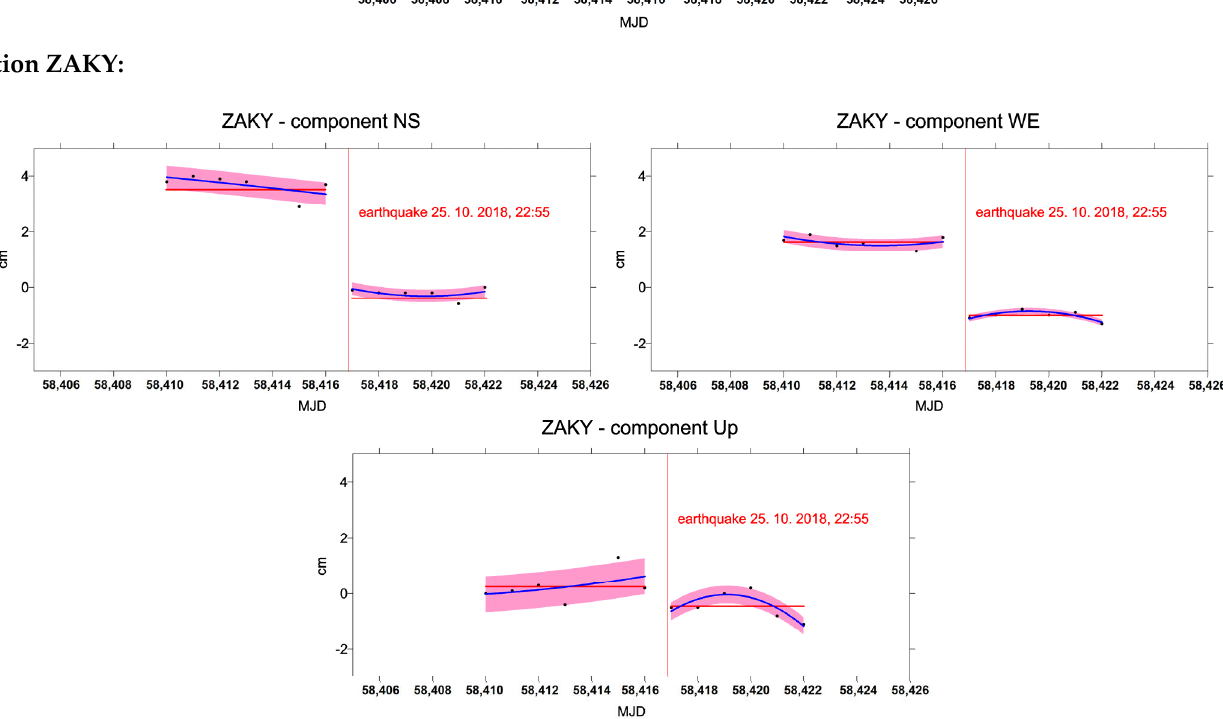
Figure 5. Results of the time series analysis during the earthquake. The horizontal red lines are approximations of averaged positions before and after the earthquakes.